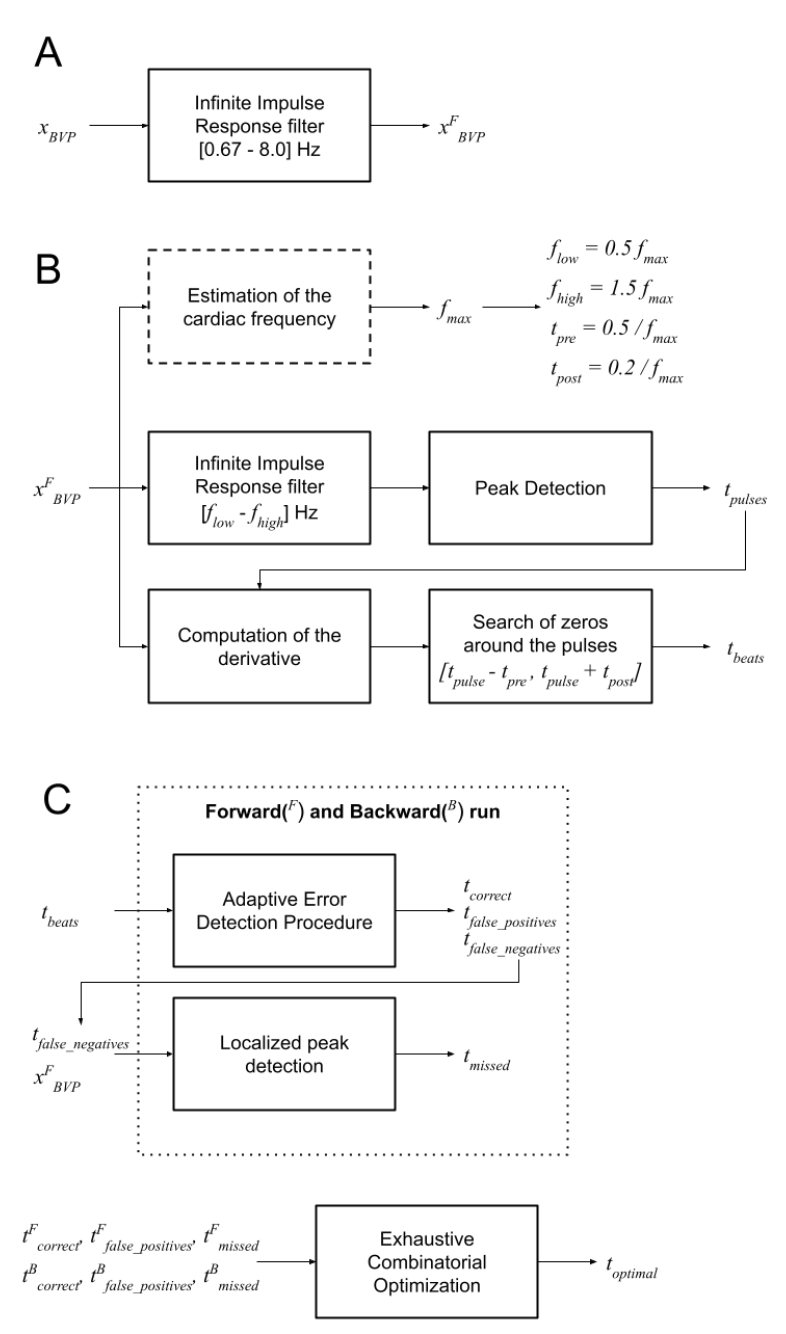
Figure 1. Schematic representation of the DBD and RCO algorithms. ( A ) Signal filtering to remove frequency components not associated with the cardiac activity; ( B ) DBD algorithm. The estimation of the cardiac frequency is optional and used in this study to automatically set the parameters of the DBD algorithm. First, the candidate instants of the heart pulses are estimated on a signal that was filtered to retain only the frequencies around the cardiac frequency. The identified pulse instants are used to center an observation window where the zero of the signal derivative is identified and selected as the heartbeat instant. ( C ) RCO algorithm. Heartbeat detection errors are identified by the Adaptive Error Detection Procedure. Potential missed detections instants (false negatives) are used to identify the target portion for the localized peak detection and obtain candidate heartbeat instants that were missed by the DBD algorithm. The procedure is executed in forward and backward directions. The optimal heartbeat instants are then computed by an exhaustive search for the optimal combination of detected beats from both